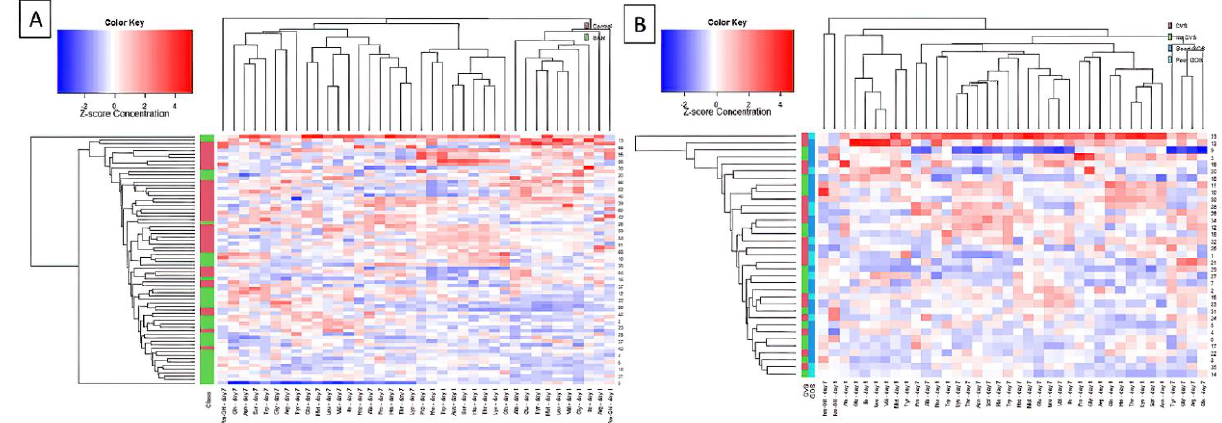
Figure 2. Heatmaps presenting standardized concentration of selected amino acids with hierarchical clustering across both amino acids and samples. ( A ) presents the comparison between SAH and control patients. SAH patients seem to cluster together. ( B ) presents intragroup clustering of patients with distinctive GOS and with or without